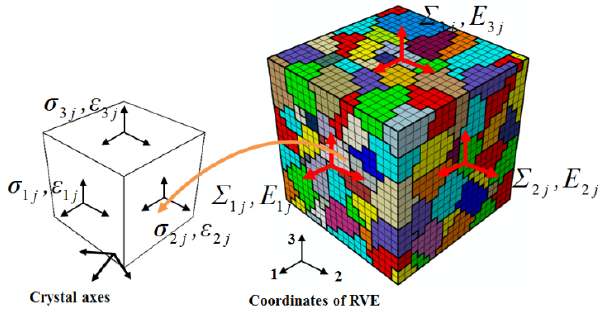
Figure 2. Local and overall stresses and strains of the representative Voronoi volume element (RVE).